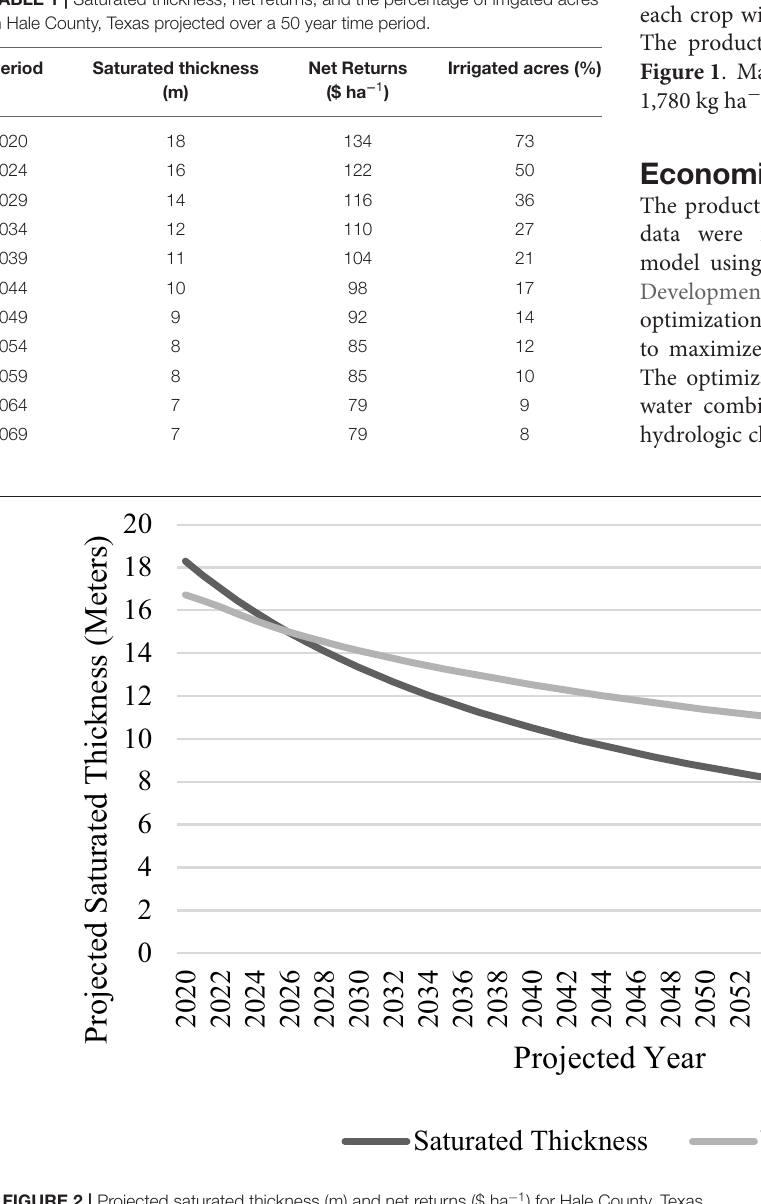
FIGURE 2 | Projected saturated thickness (m) and net returns ($ ha − 1 ) for Hale County, Texas.